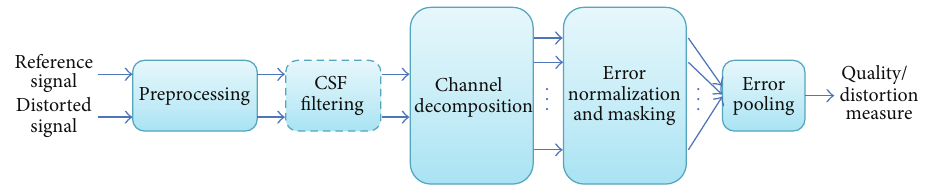
Figure 2: Common block diagram of the error sensitivity